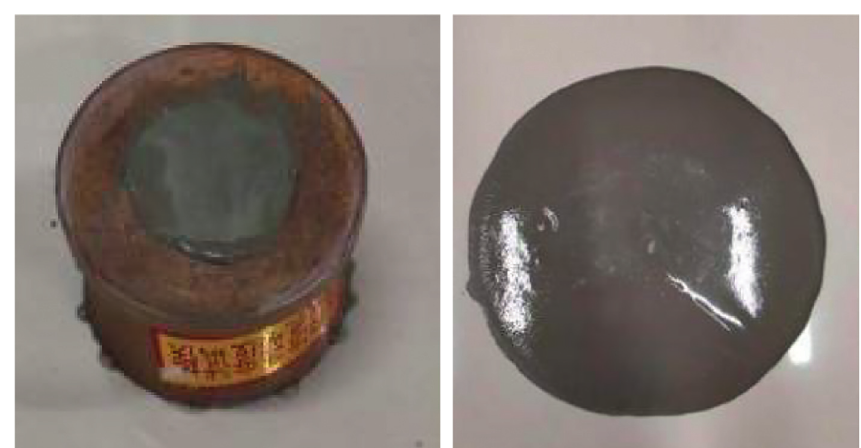
Figure 2: The test of material